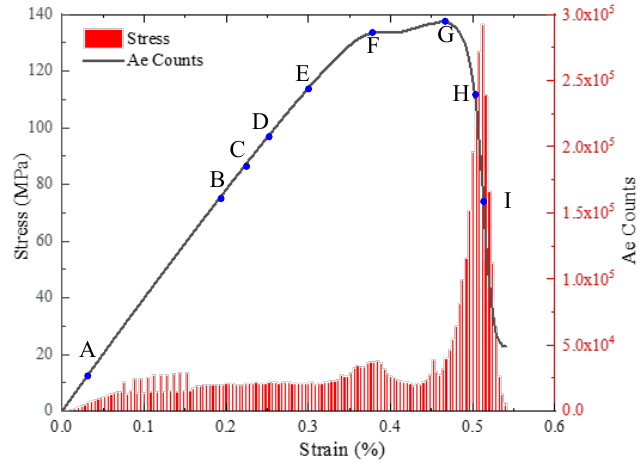
Figure 15. The stress–strain curve associated with AE counts for CJRM. The stress–strain curves of CJRM are different from those of intact rock samples, and the brittle characteristics of intact rocks are significantly higher than those of CJRM. The stress–strain curve and the AE count for CJRM are shown in Figure 15. There is a stepwise increase when the curve rises to the DE stage before the peak strength. The strain increases from 0.36% to 0.46% at this stage, an increase of 27.8%. The stress increases from 131.2 MPa to 137.5 MPa, a rise of 4.8%. This may be due to the crushed low-angle horizontal joints and the longitudinal blocks being squeezed. After the peak strength, the stress–strain curve of the complete rock sample under uniaxial compression generally decreases